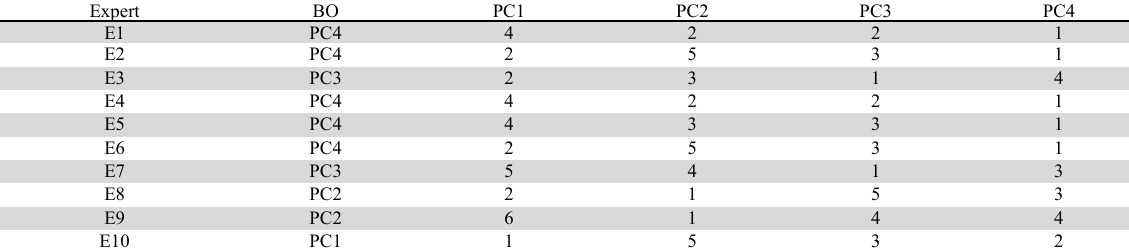
Process challenge preferences (Best to others) Expert